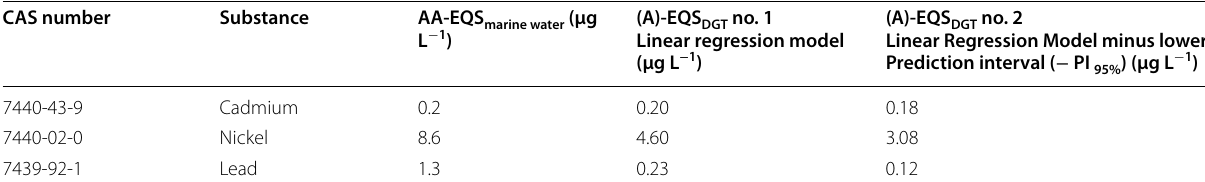
for Cd, Pb and Ni DGT